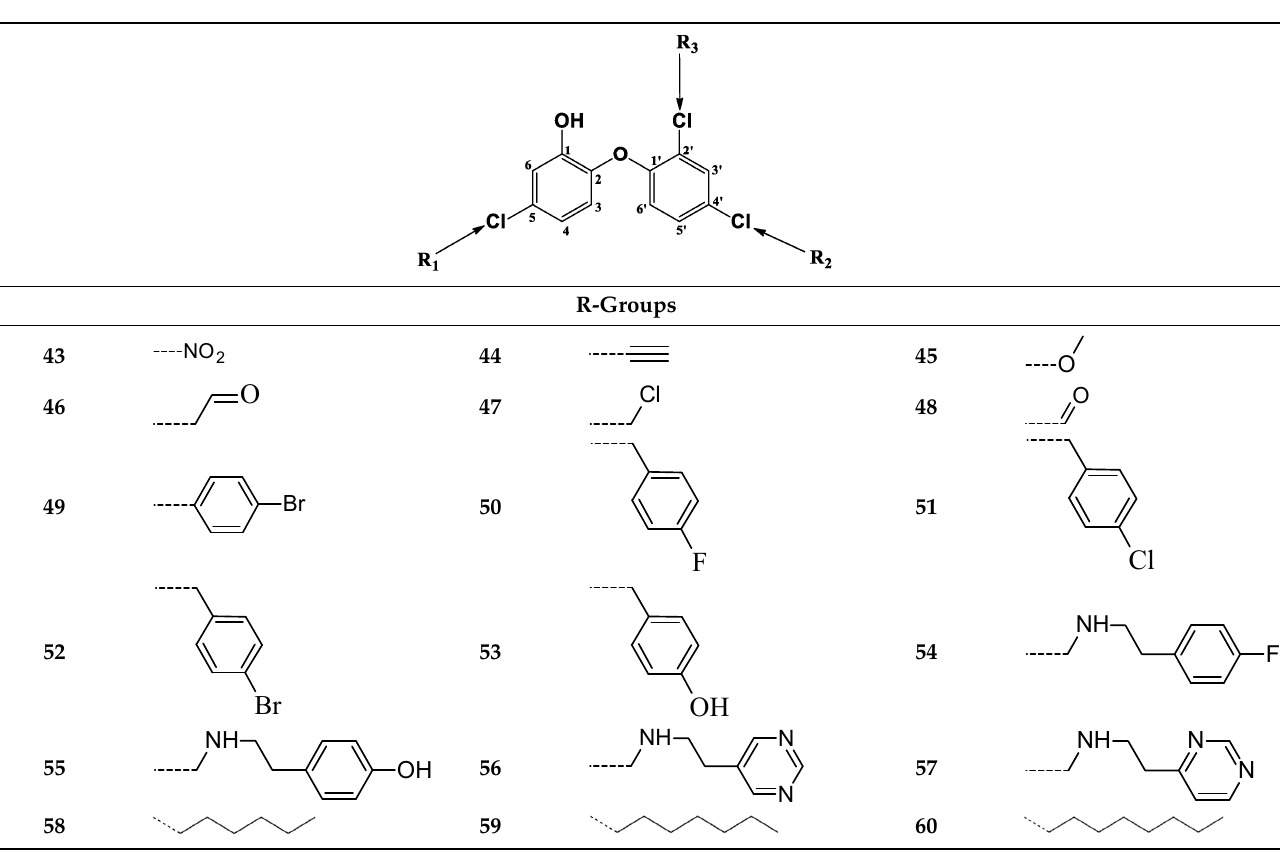
Dashed bonds indicate the attachment point of the fragment. R (cid:2869) ‐ groups: fragments 1 – 60 ; R (cid:2870) ‐ groups: fragments 1 – 23 ; 41 – 48 . R (cid:2871) ‐ groups: fragments 1 – 11 ; 41 – 47 .